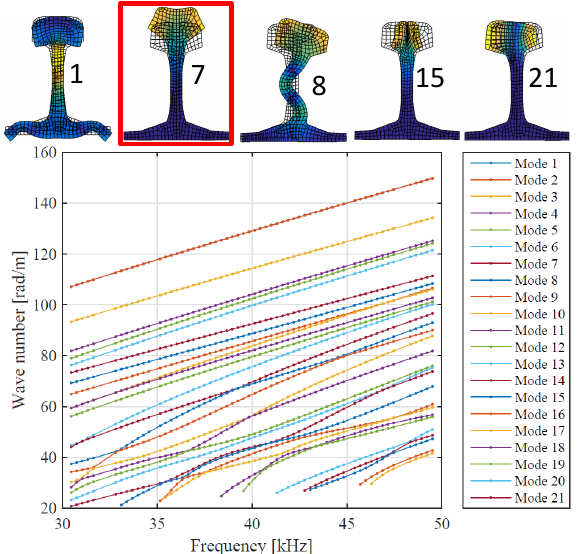
Figure 3. Dispersion curves of propagative modes supported by the UIC60 rail considered, with selected mode shapes